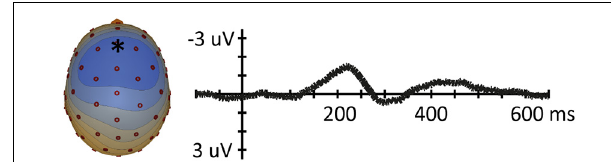
FIGURE 3 | (Left) Overall MMN voltage topography map ( µ V) for the 5 ms time-window around the average MMN peak latency (218 ms). Blue in topoplot indicates negative potential, red positive potential. (Right) MMN waveforms at frontal electrode position